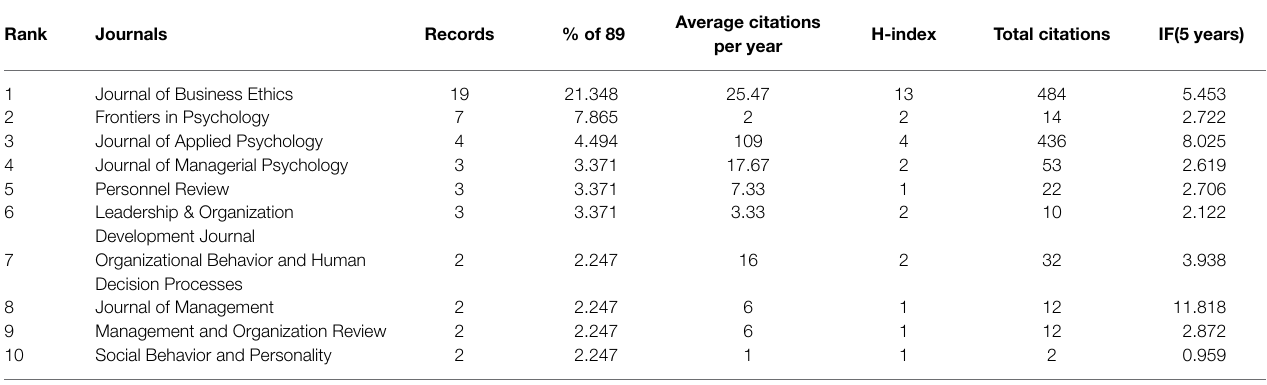
TABLE 3 | The top 10 Most influential journals in UPB research.